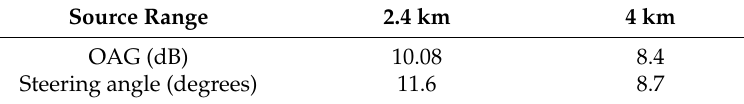
Table 1. The values of the optimal array gain under the above two experimental